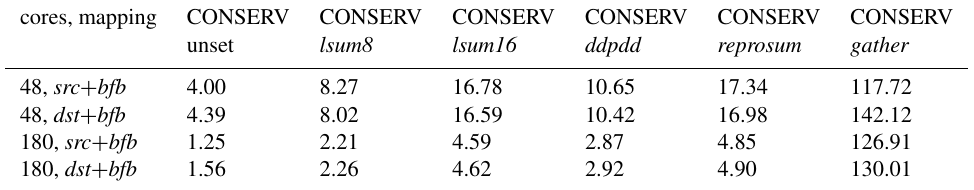
Table 3. Comparison of ping-pong (pipo) times for the T799-ORCA025 toy model on Lenovo on 48 and 180 cores per model with the CONSERV option off (unset), set to lsum8 ( opt in OASIS3-MCT_3.0), lsum16 , ddpdd , reprosum , and gather ( bfb in OASIS3-MCT). Times are accumulated over 1000 ping-pongs for a single coupling field in each